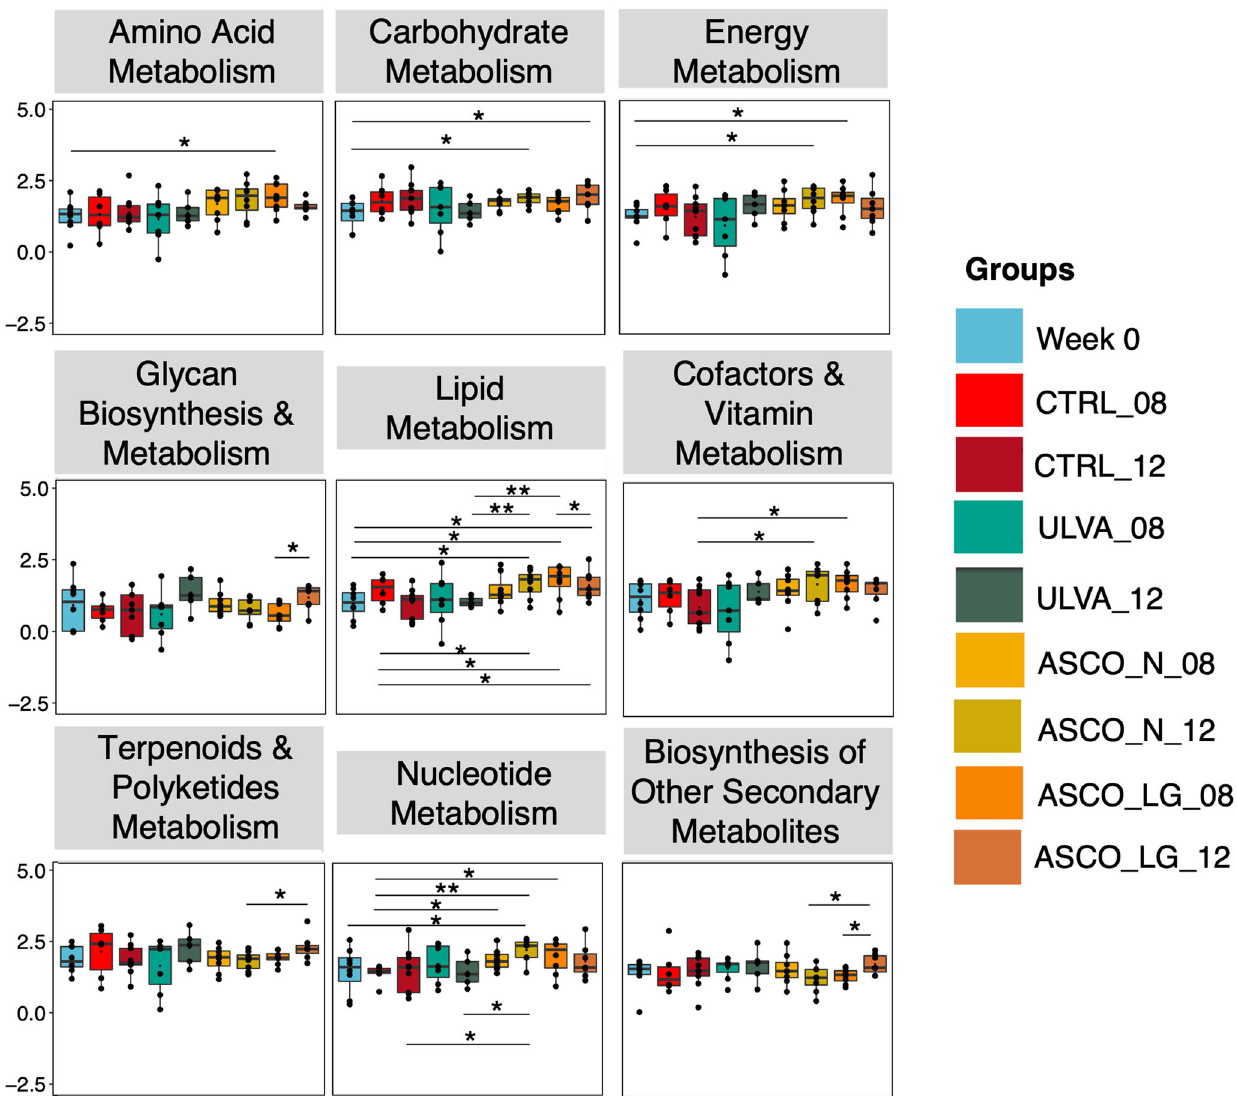
Fig. 6 How robust are speci fi c functions in the gut microbiota of Atlantic cod? Potential robustness to speci fi c functional superpathways related to metabolism and cell function were signi fi cantly increased over time. In the boxplots, center value lines indicate the median, boxes indicate the lower/upper quartiles (25%/75%) and lines extending parallel from the boxes (whiskers) show the variability outside the upper and lower quartiles. Lines connecting categories shows signi fi cant relationships (pairwise t-test) with *( p < 0.05), **( p < 0.01), or ***( p <